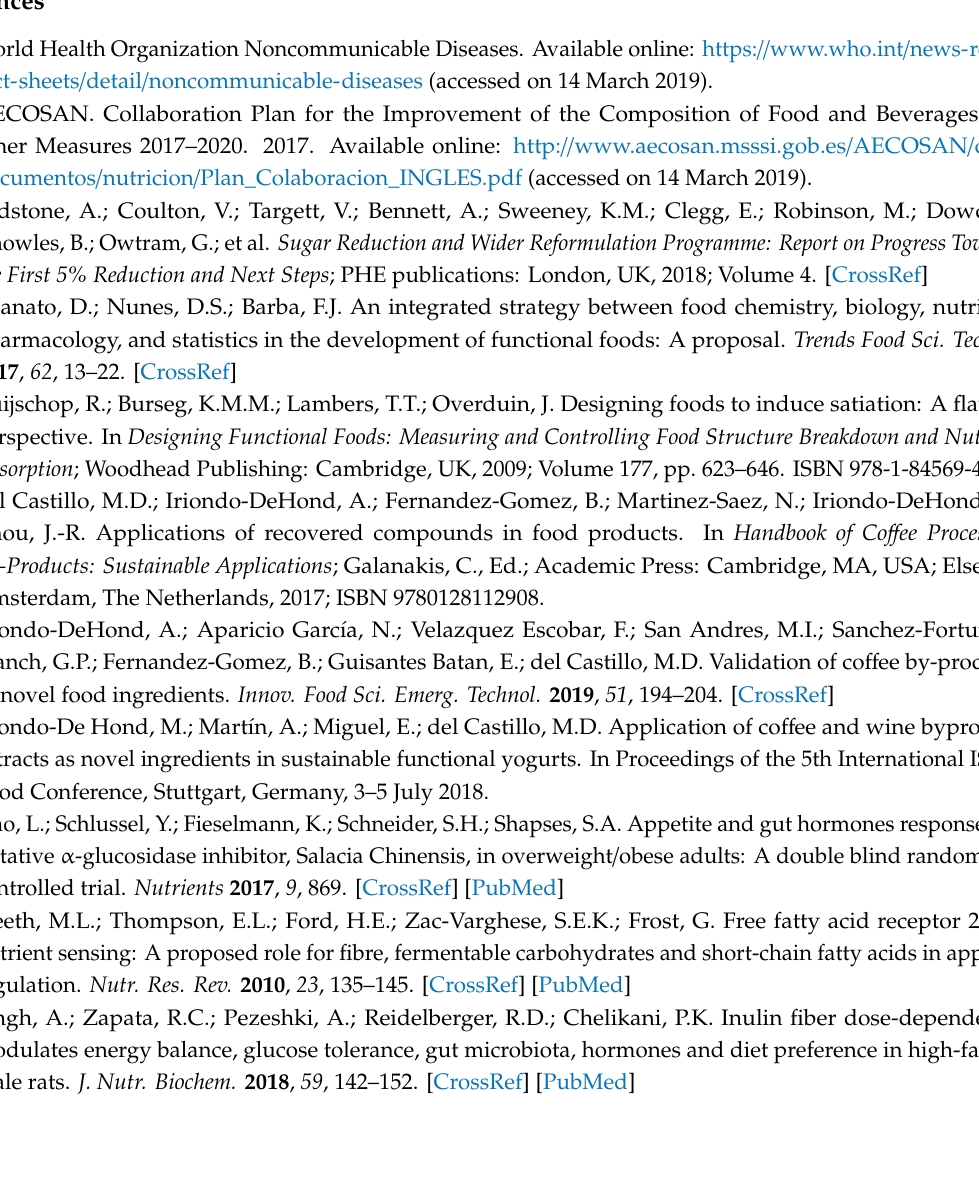
Figure S1: E ff ect on α -glucosidase activity is represented by dose-response curves of the standard inhibitor acarbose (0.06 µ g / mL–6.5 mg / mL) and co ff ee-cascara byproduct (0.01–4 mg / mL). Values represent mean ± standard deviation. This includes a duplicate of sample preparation and a triplicate of